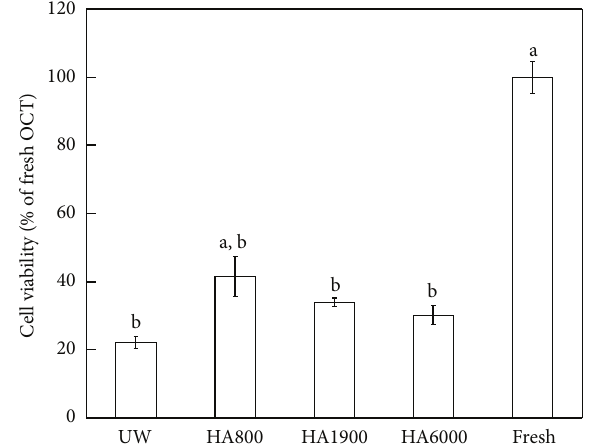
Figure 3: Effect of hyaluronic acid on cell viability in OCT after cold preservation for two weeks in UW solution. Data are presented as the mean ± SE ( 𝑛 = 10 ). a Significant difference between the UW and UW with HA groups ( 𝑃 < 0.05 ). b Significant difference between the nonpreserved OCT and UW and UW with HA groups ( 𝑃 < 0.05 ). Fresh: nonpreserved OCT